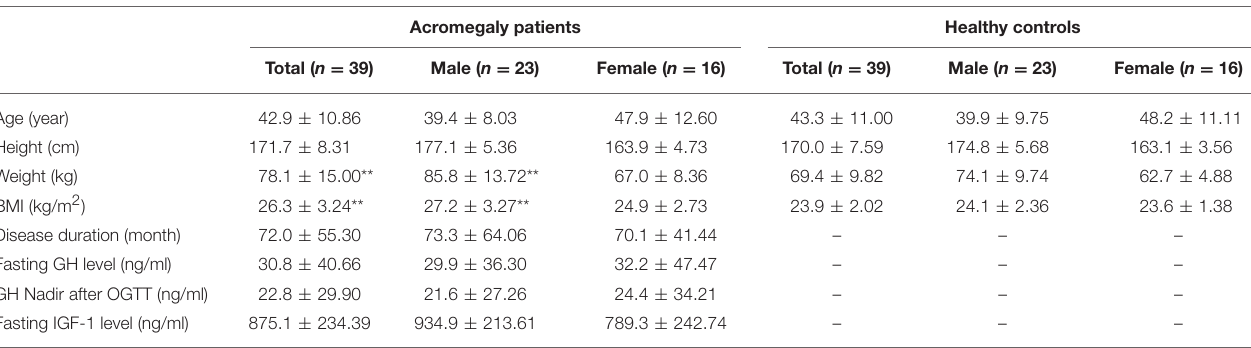
TABLE 1 | General information of the